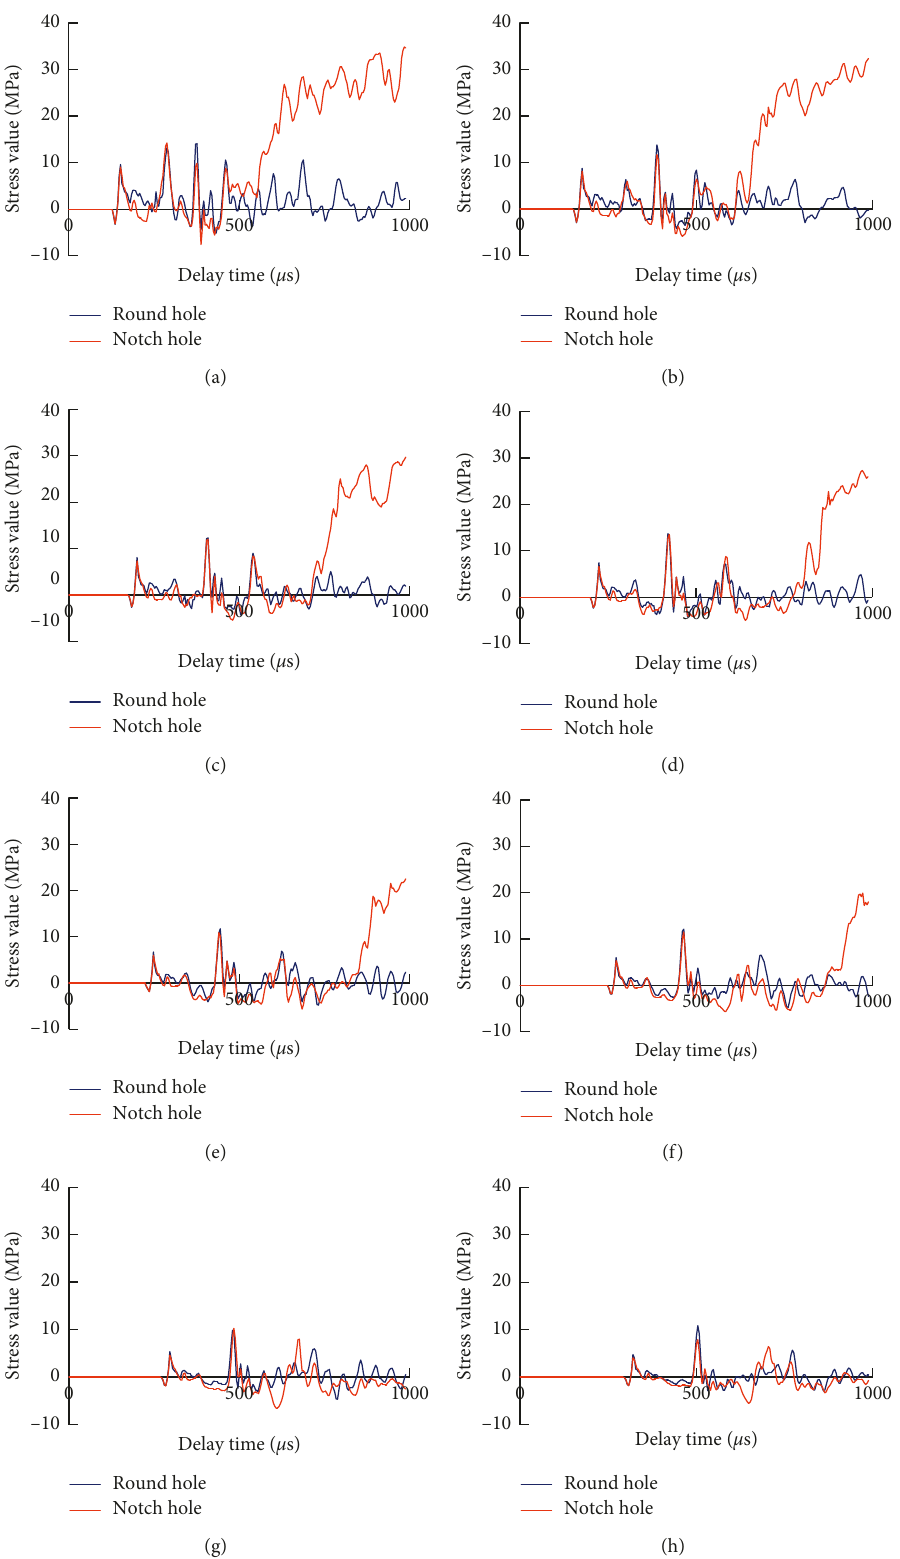
Figure 20: The stress curve of TBH hole wall measuring element b1 before TBH initiation. (a) H � 50cm. (b) H � 60cm. (c) H � 70cm. (d) H � 80cm. (e) H � 90cm. (f) H � 100cm. (g) H � 110cm. (h) H �